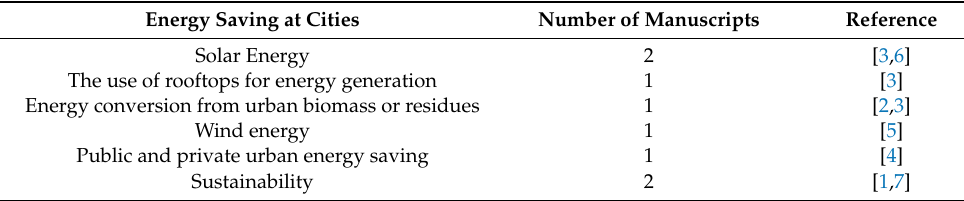
Table 3. Energy Saving at